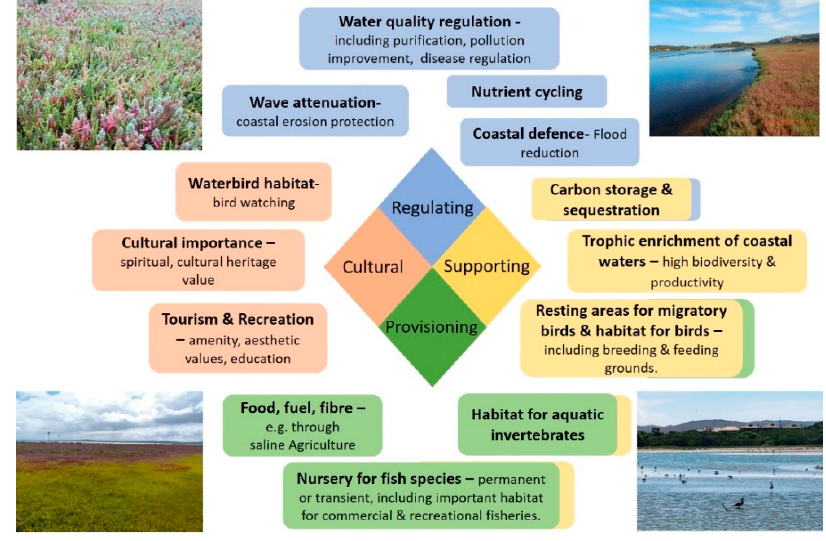
Figure 2. Ecosystem services provided by salt marshes.